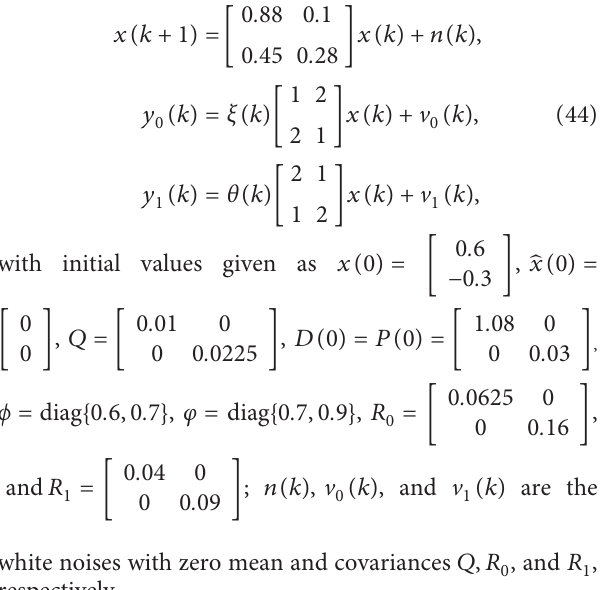
Figure 1: The first state component x (delay).